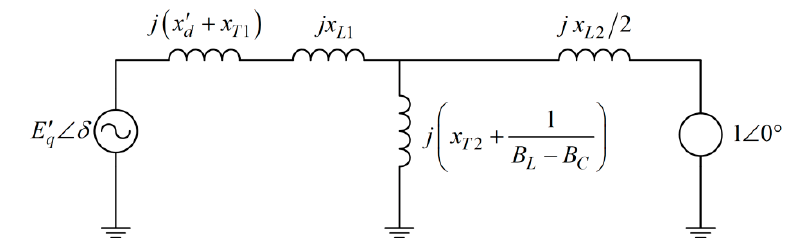
Figure 4. Post-fault equivalent circuit.